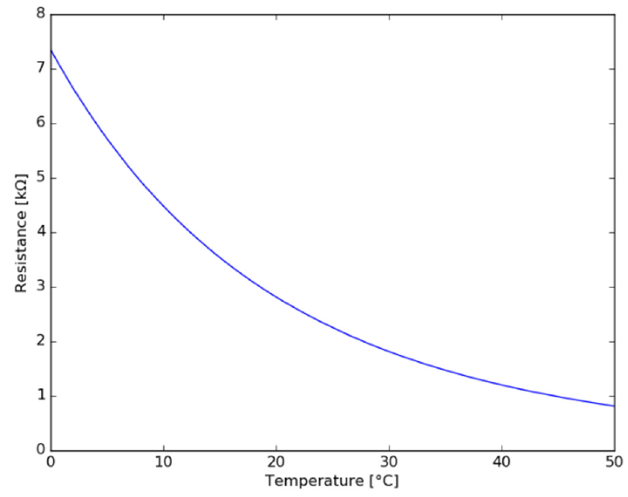
Figure 1. A sample thermistor curve. Human body temperature will be measured in the range between +25 ◦ C and +45 ◦